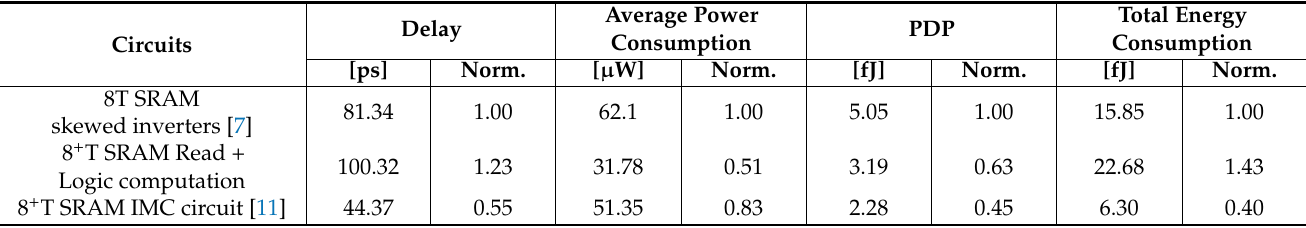
Table 2. Comparison of logic computation performance and energy consumption in different